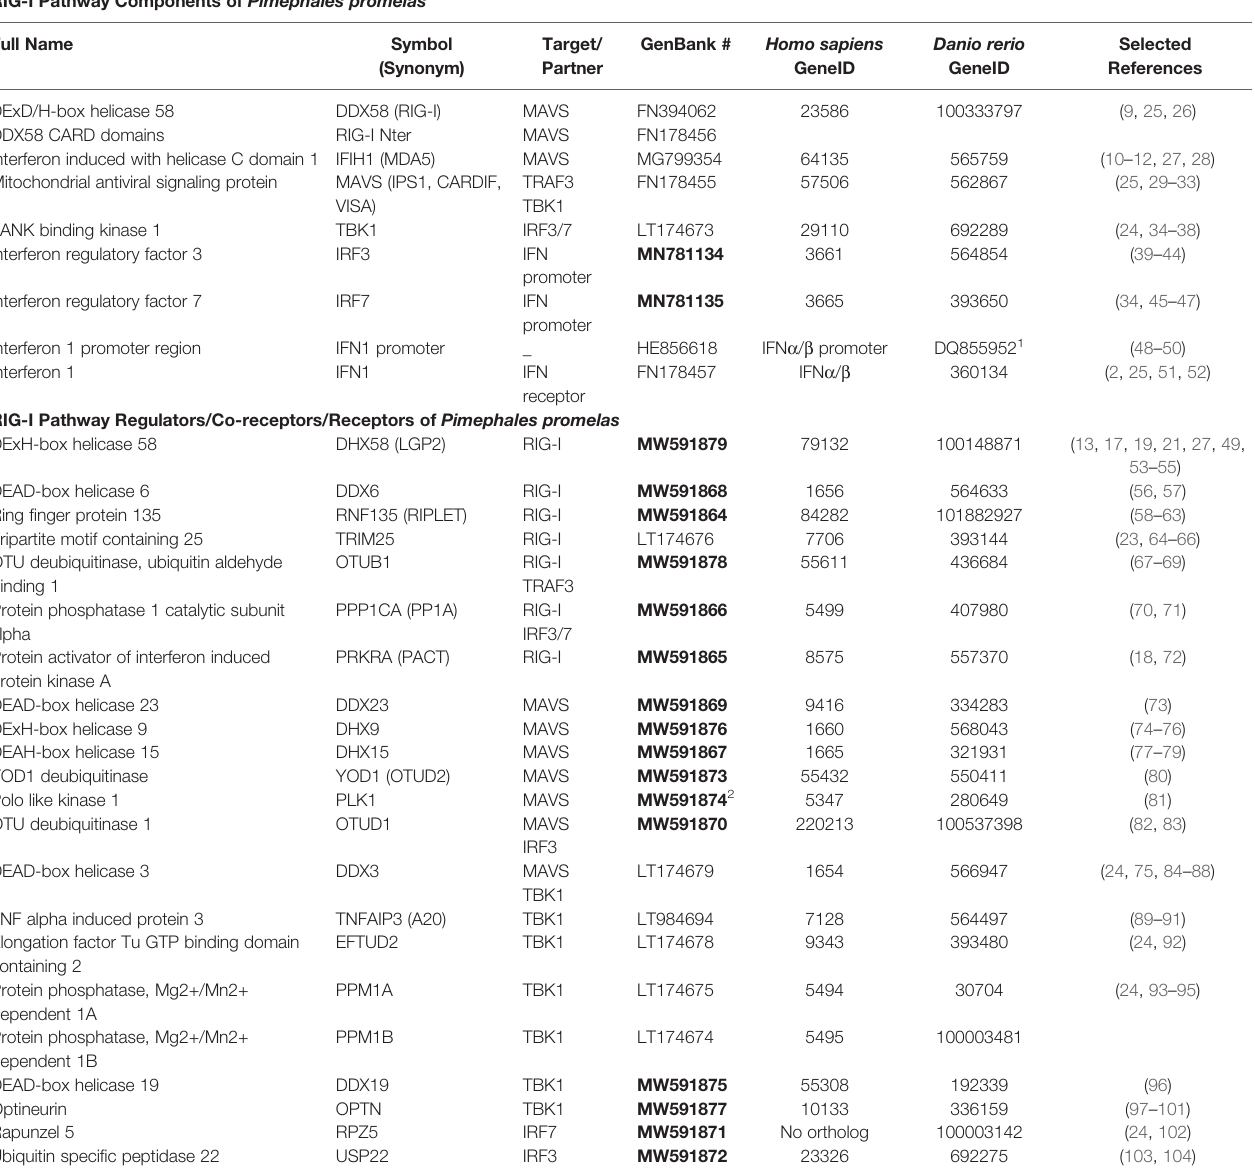
TABLE 1 | Pimephales promelas RIG-I pathway components and orthologs. RIG-I Pathway Components of Pimephales